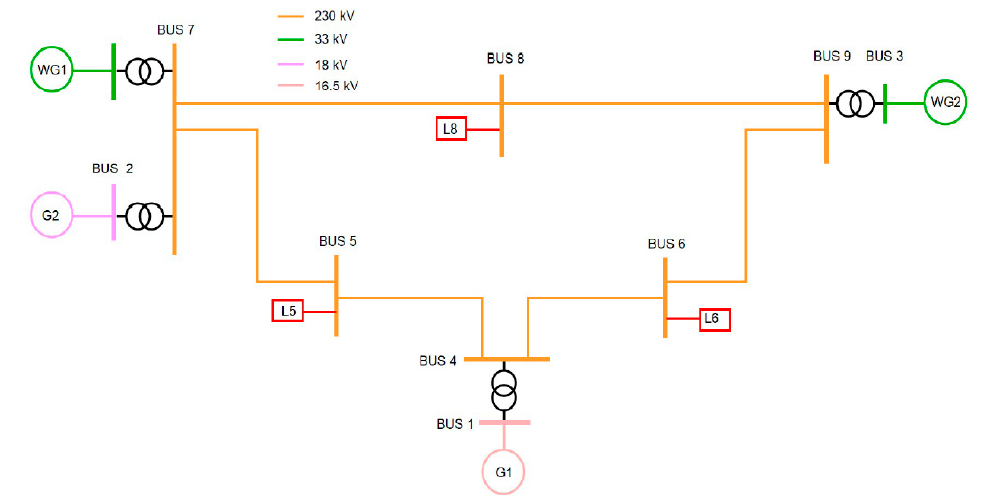
Figure 8. Used variant of the IEEE 9 bus test system, taking into account 52% supply from wind power generation. Table 1. Steady-state profile before the occurrence of an active power imbalance.